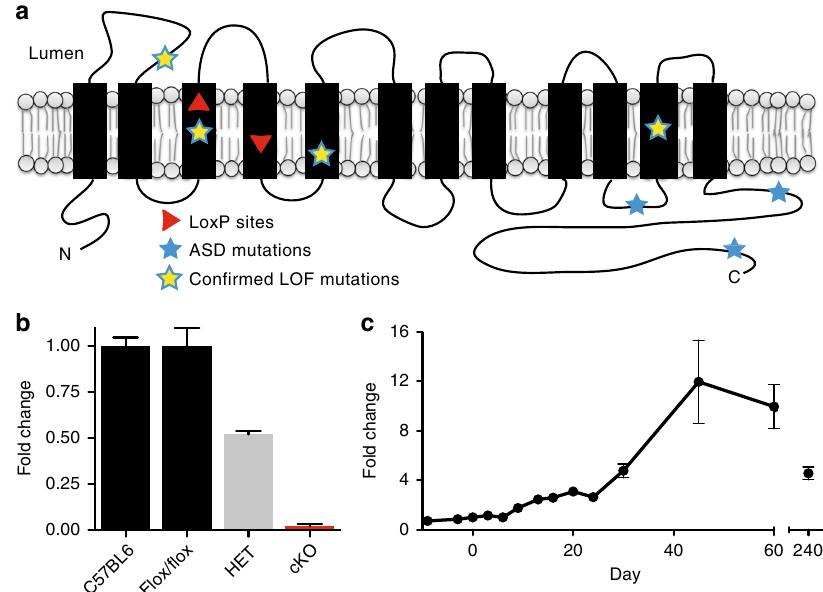
Fig. 1 Conditional knockout and developmental expression of NHE9. a Diagram shows the 12 predicted transmembrane domains (TMDs) of NHE9 and the location of two loxP sites (red arrowheads) between TMD3 and TMD4. Asterisks indicate the location of ASD-associated mutations. b Quantitative RT- PCR demonstrates the reduction in brain NHE9 mRNA from, respectively, heterozygous and conditional knockout (cKO) animals relative to WT and those with unrecombined alleles ( fl ox/ fl ox). Bars indicate the mean and error bars s.e.m. n = 2 – 4 animals/genotype. c Time course of brain NHE9 expression (by quantitative RT-PCR) from embryo to adulthood in wild-type C57Bl/6 mice. The data indicate mean ± s.e.m. n = 3 mice/time